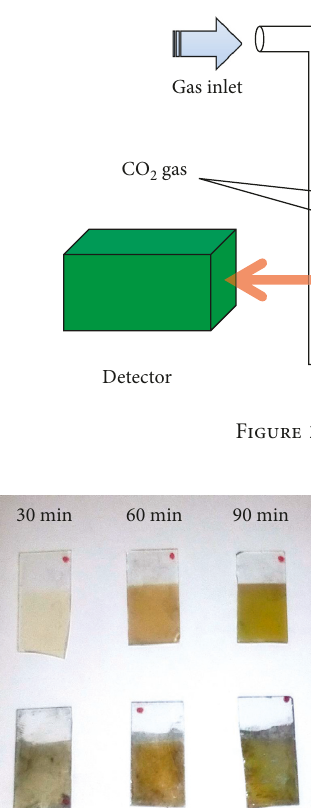
2 thin films on